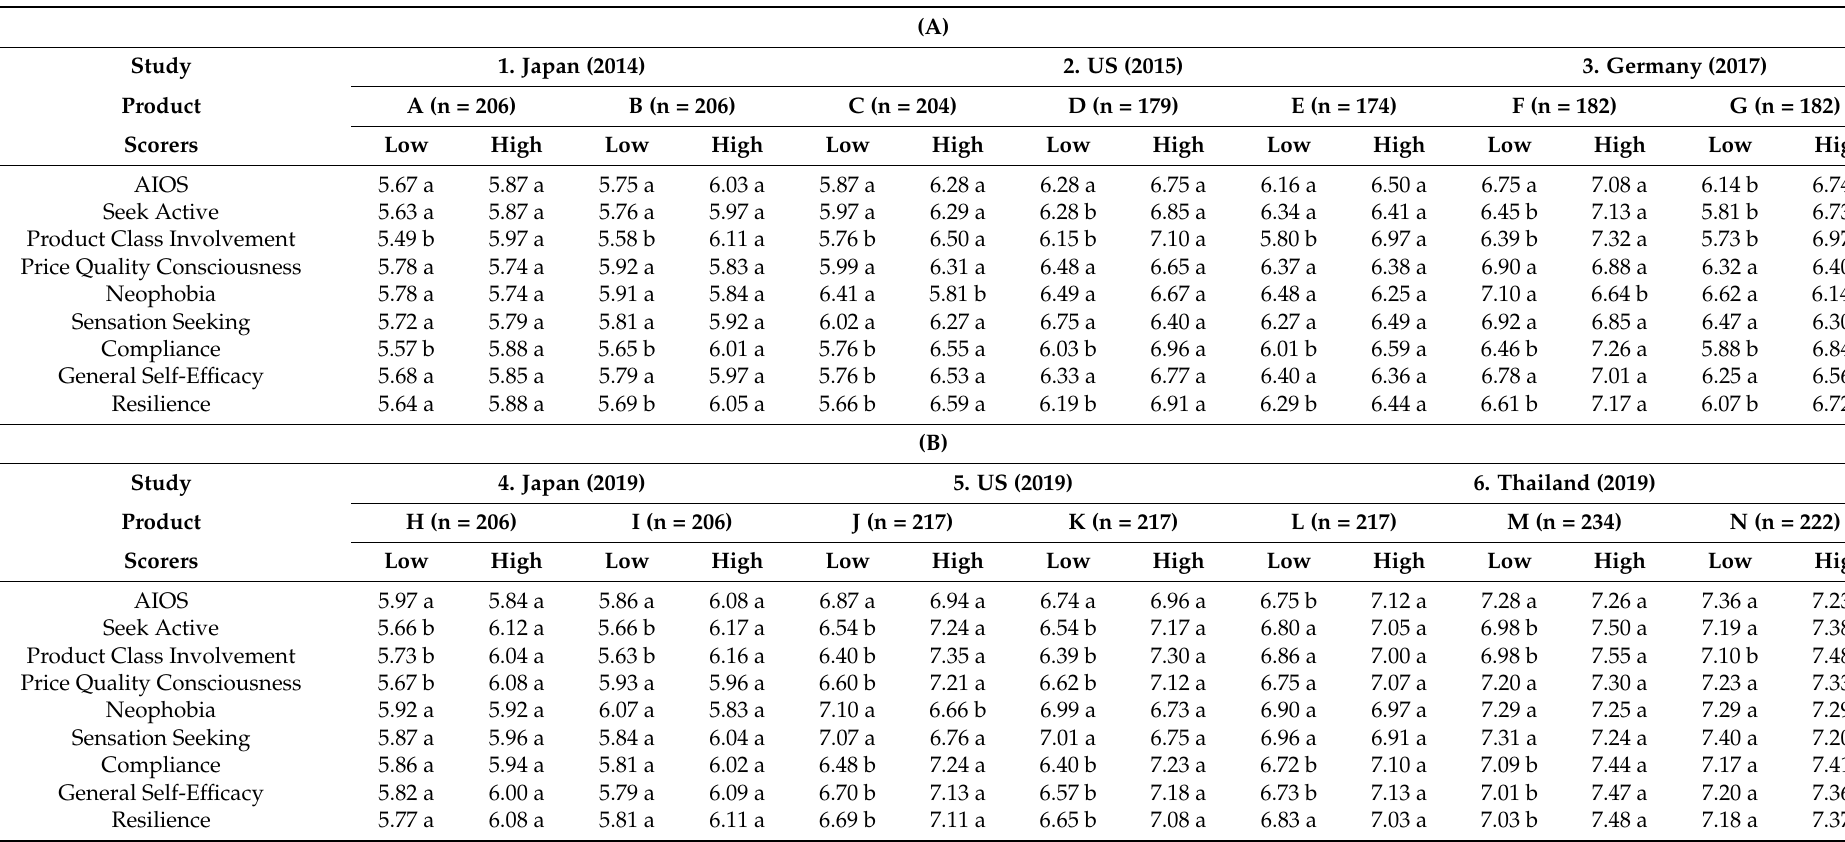
Table 8. ( A ). Studies 1–3: average overall liking (Mon and Fri) by psychographic group (low and high). ( B ). Studies 4–6: average overall liking (Monday and Friday) by psychographic group (low and